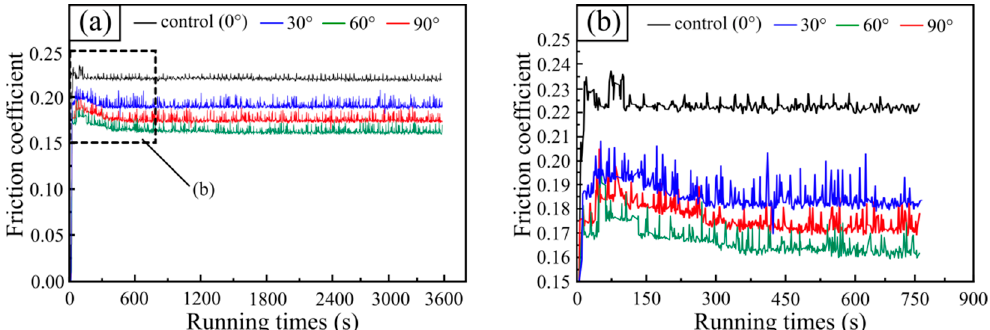
Figure 7. ( a ) Friction coefficients at functions of time at different jet angles; ( b ) friction coefficients during the running-in stage.